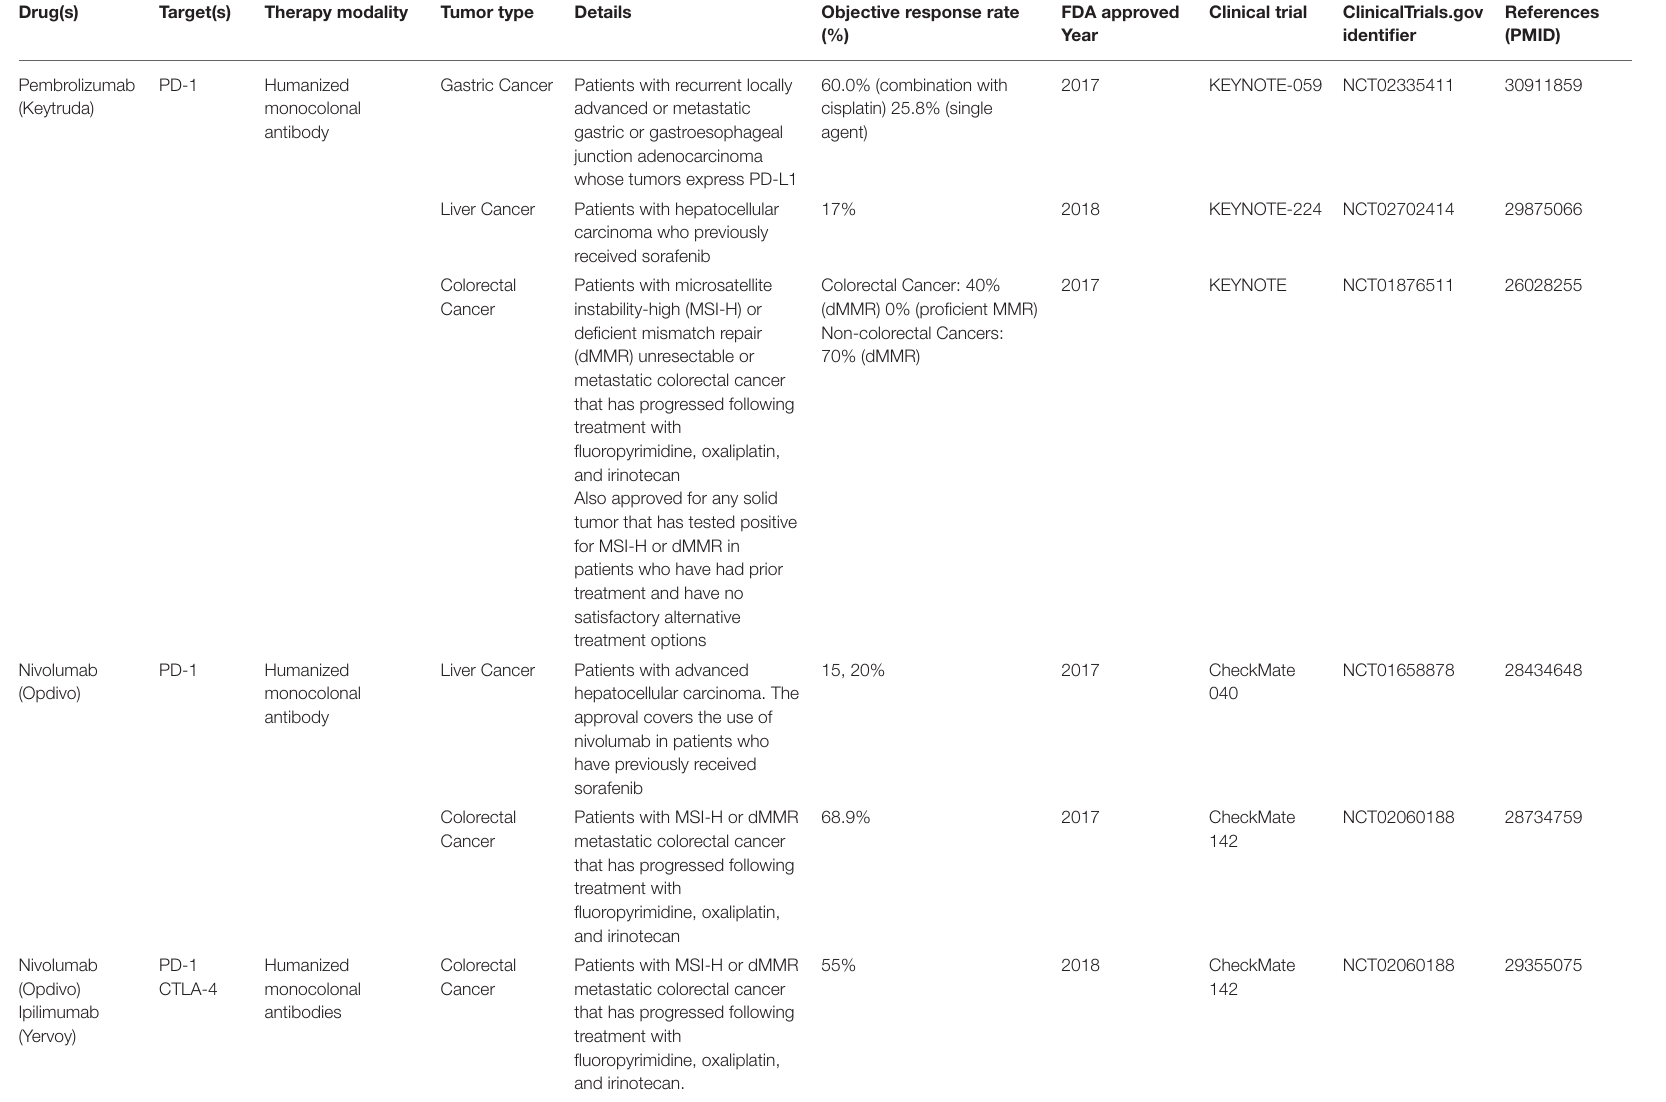
TABLE 1 | Summary of Food and Drug Administration approved immune checkpoint inhibitors in GI